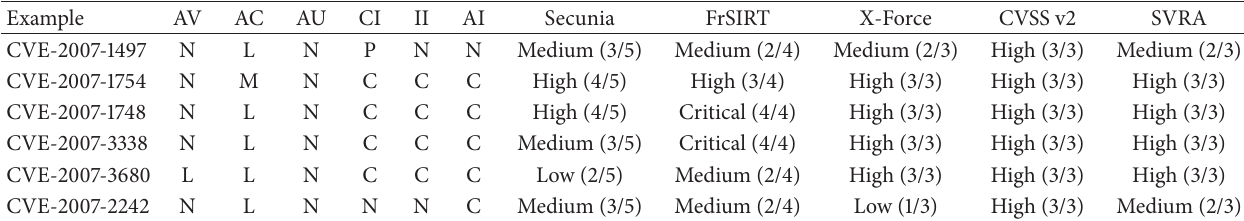
Table 7: Comparison of rating results.